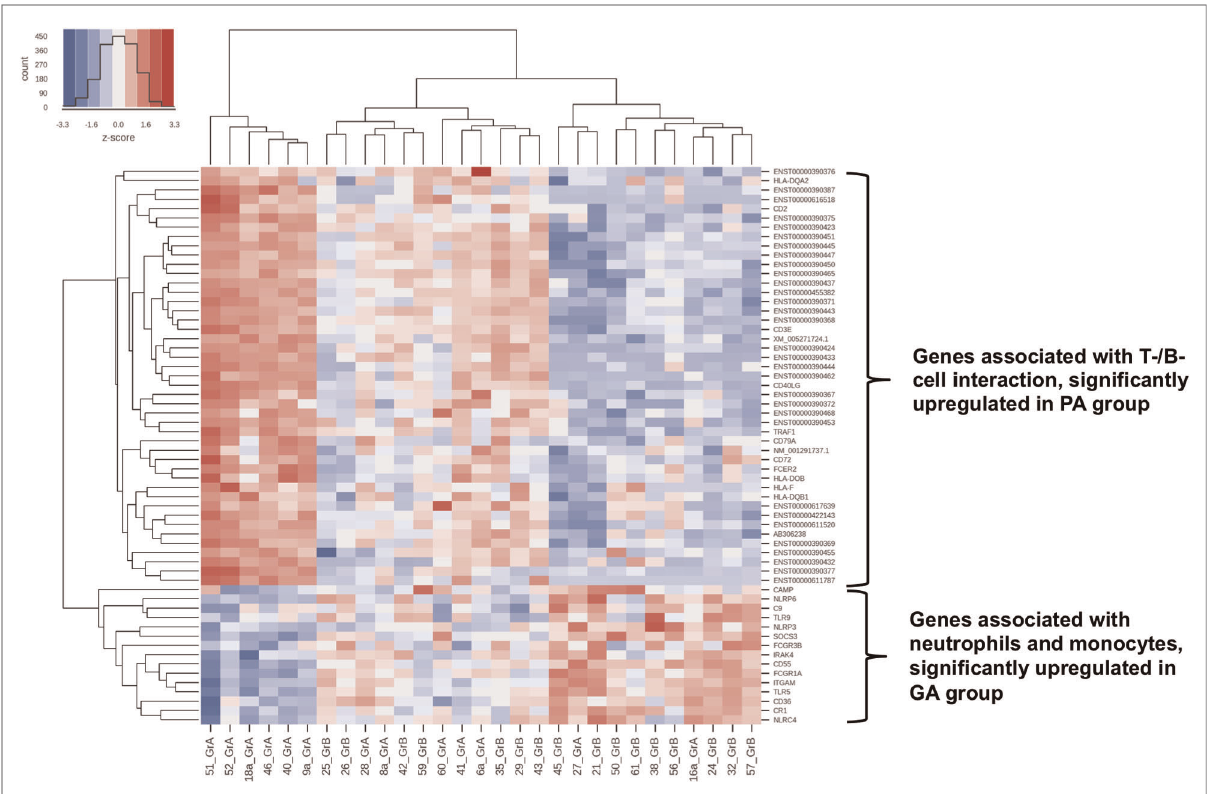
FIGURE 2 Heat map: cluster formation of samples with similar immunological patterns within genome wide gene expression analysis with RNA-microarray (40). Differentially expressed pathways according to the Generally Applicable Gene-set Enrichment (GAGE) method by Luo et al. using the “ gage ” package in R (48).: Toll and lmg signaling pathway, Antigen processing and presentation, NOD-like receptor signaling pathway, Hematopoietic cell lineage, Natural killer cell-mediated cytotoxicity, TNF signaling pathway and Intestinal immune network for IgA production, Complement and coagulation pathways, RIG-I-like receptor signaling pathway, Cytosolic DNA-sensing pathway, C-type lectin receptor signaling pathway, T-cell receptor signaling pathway, Th1 and Th2 cell differentiation, Th17 cell differentiation, IL-17 signaling pathway, Fc epsilon RI signaling pathway, Fc gamma R-mediated phagocytosis and Chemokine signaling pathway. ( A ) samples from patients with phlegmonous appendicitis (PA); ( B ) samples from patients with gangrenous appendicitis (GA); red colour: signal above mean signal, blue colour: below mean signal.